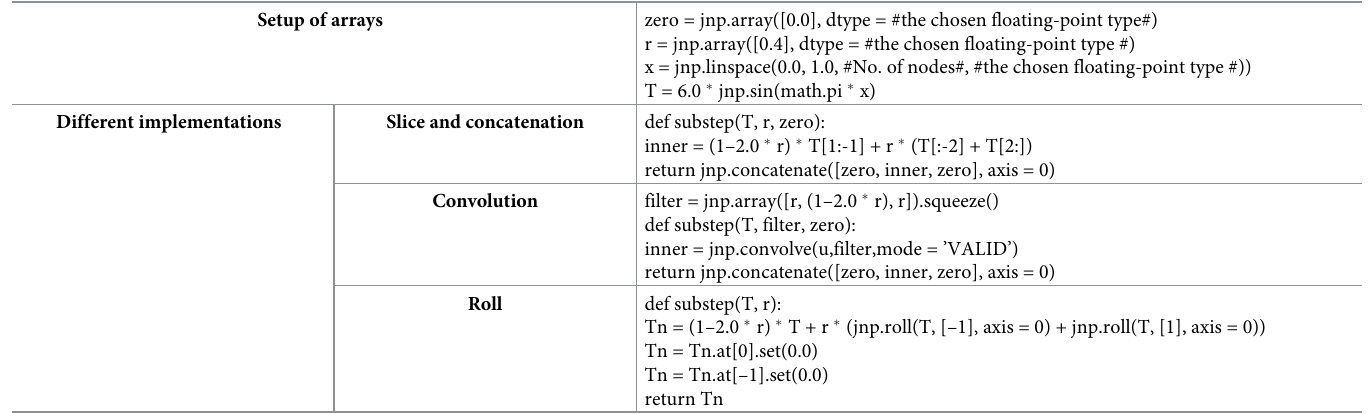
Table 2. Implementation of the 1D heat model with array programming. Setup of